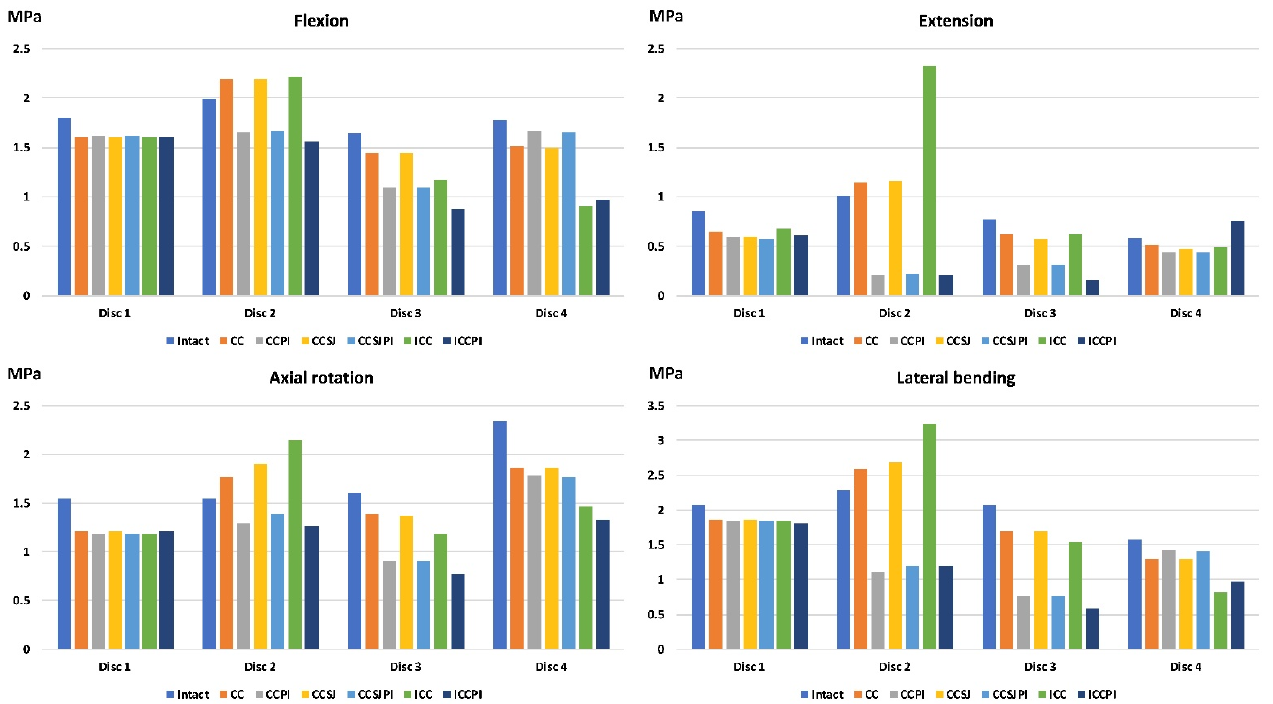
Figure 7. The results of nucleus stress.